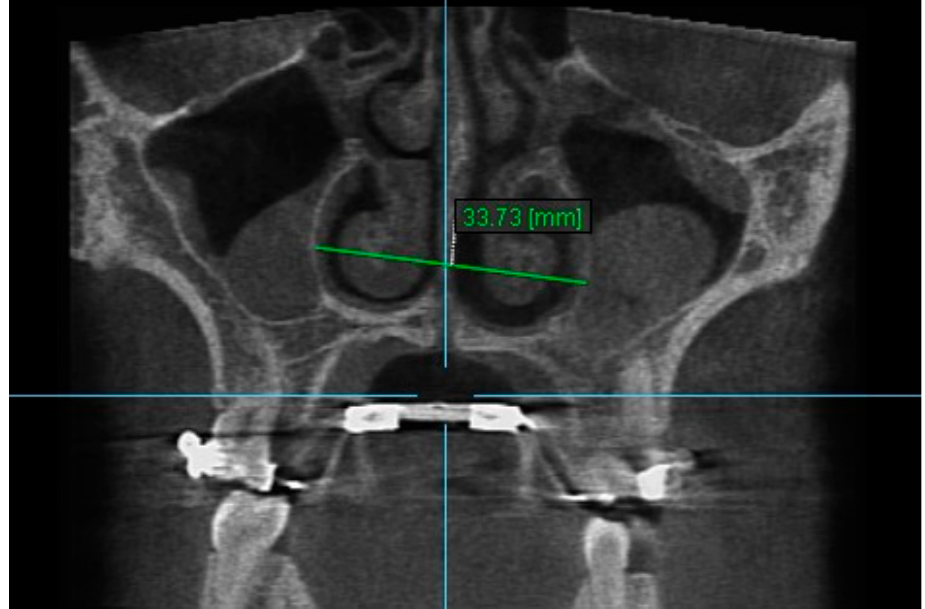
Figure 3. Nasal Width 1. through the center of the root of the second premolar (Figure 4).